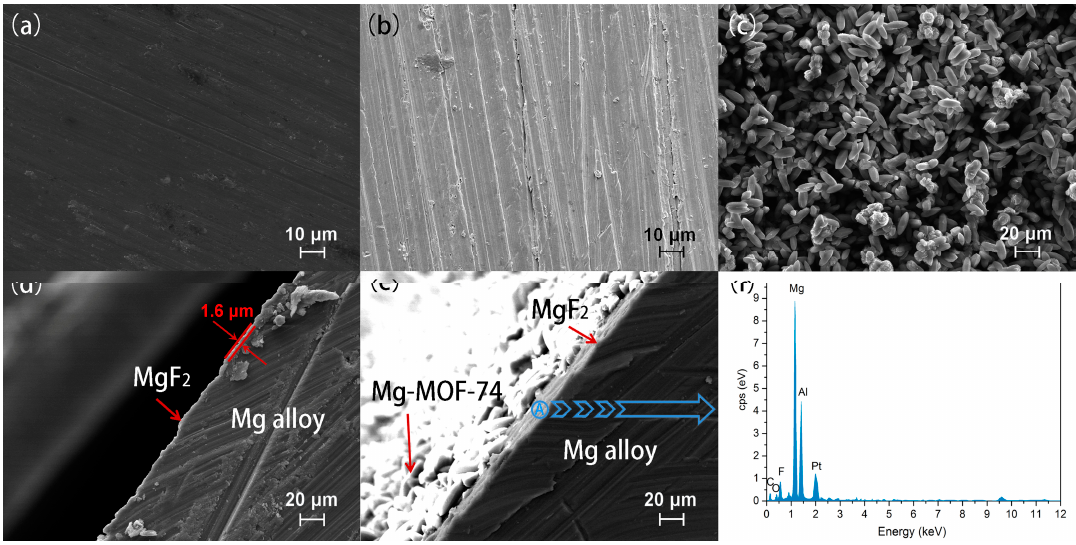
Figure 2. SEM images. The vertical view of ( a ) bare Mg alloy, ( b ) MgF 2 -coated Mg alloy, and ( c ) Mg-MOF-74/MgF 2 -coated Mg alloy; the cross-sectional view of ( d ) MgF 2 -coated Mg alloy and ( e ) Mg-MOF-74/MgF 2 -coated Mg alloy; ( f ) the EDS spectrum on MgF 2 middle layer.